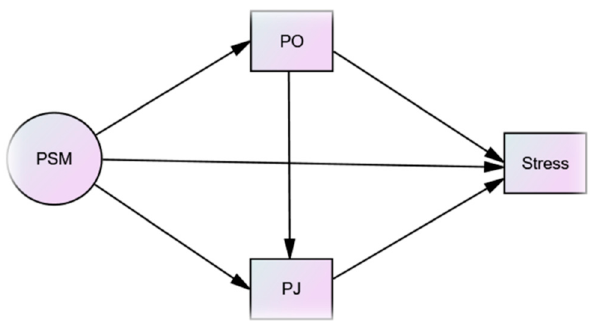
Figure 1. Study model.